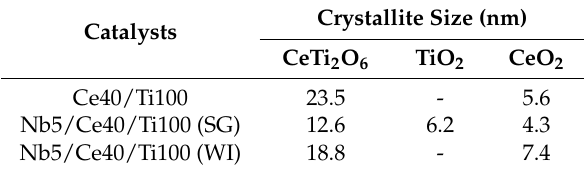
Figure 4. XRD patterns of the fresh catalysts. Table 2. Crystallite sizes of prepared catalysts calculated with Scherrer’s formula [43].